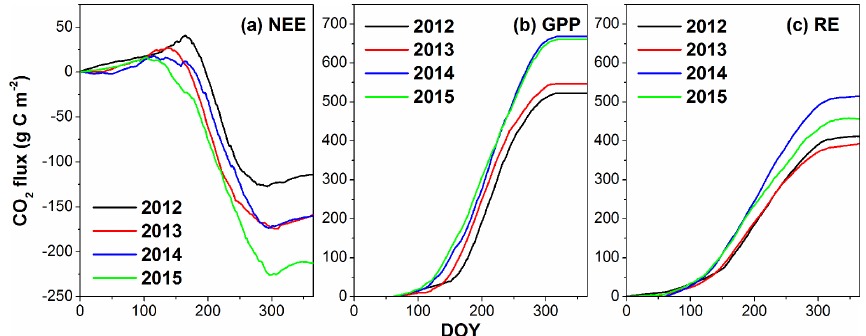
Figure 5. The cumulative NEE, GPP and RE from 2012 to 2015.